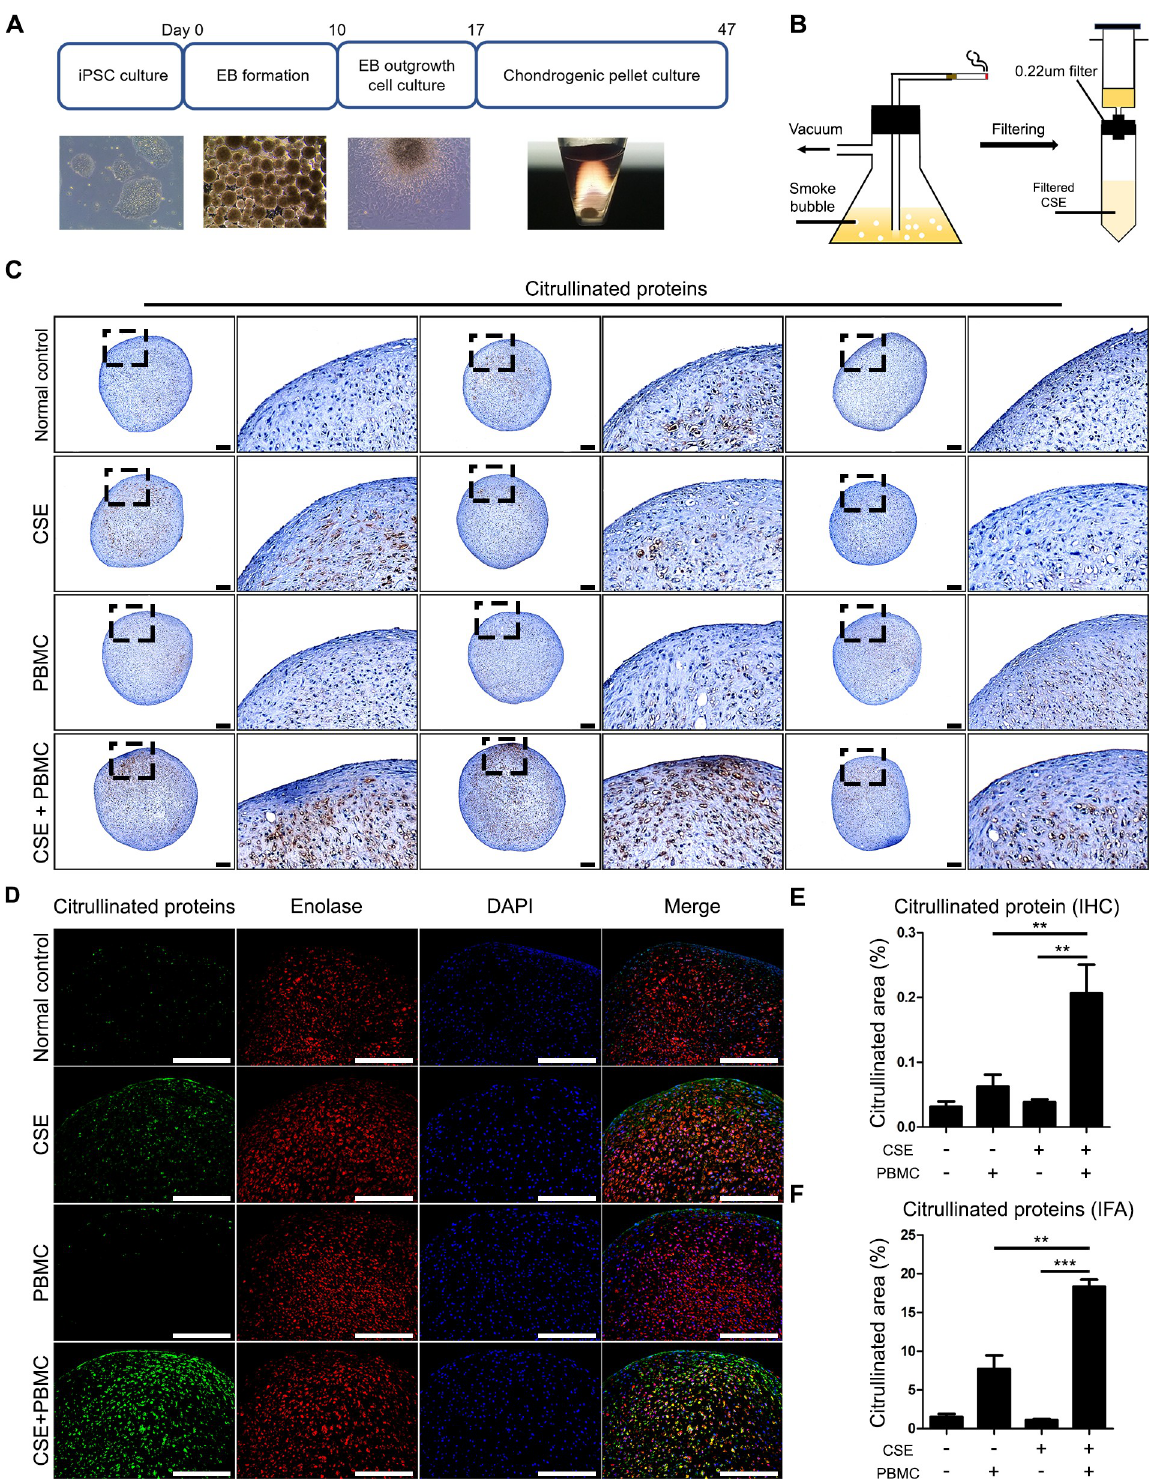
Fig 5. Cigarette smoke extract affects citrullination of iPSC-derived chondrogenic pellets. (A) Schematic diagram of chondrogenic pellets from iPSCs for each stage of chondrogenic differentiation. (B) Schematic diagram of cigarette smoke extract preparation. Cigarette smoke was dissolved in PBS and filtered sterilized with a 0.22 μ m filter before treatment. (C) Immunohistochemical staining was performed to confirm citrullinated proteins in chondrogenic pellet. (D) Immunofluorescence Assay showing co-localization of enolase and citrullinated proteins in